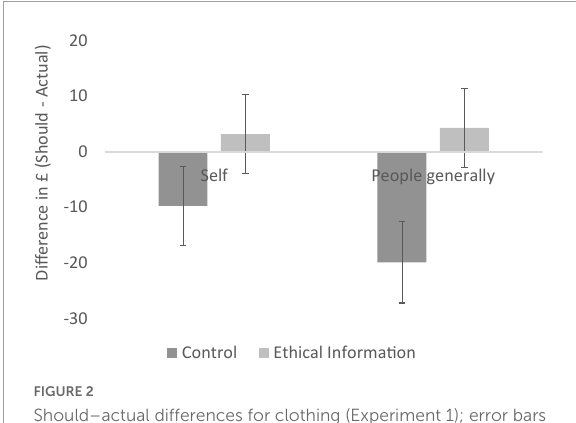
FIGURE2 Should–actual differences for clothing (Experiment 1); error bars show 95% confidence